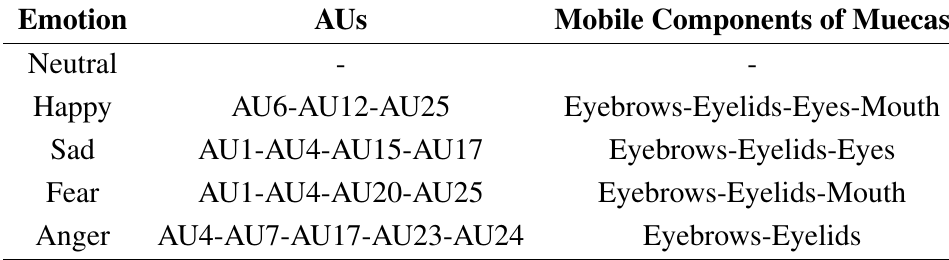
Table 5. Movements of the robotic head, Muecas, and mobile elements associated with each emotional